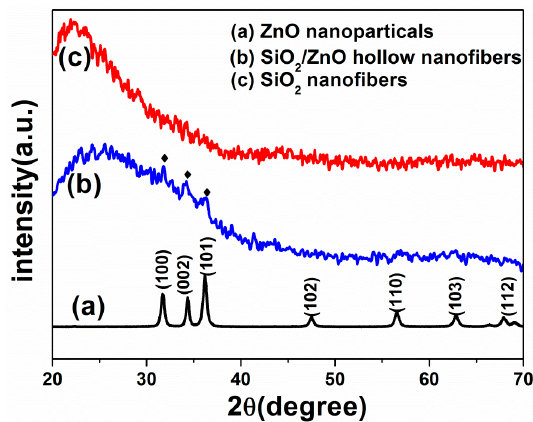
Figure 2. X-ray diffraction (XRD) patterns of ( a ) ZnO nanoparticles, ( b ) SiO 2 /ZnO composite hollow sub-micron fibers and ( c ) pure SiO 2 sub-micron fibers.